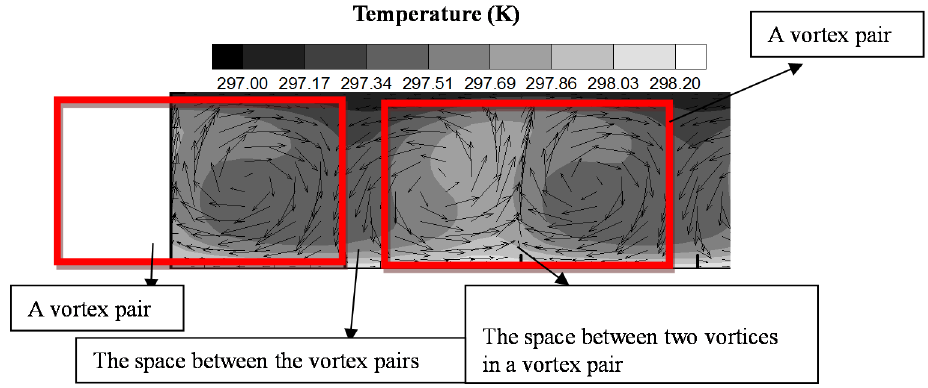
Figure 10. Velocity field and temperature distribution of a vortex pair.